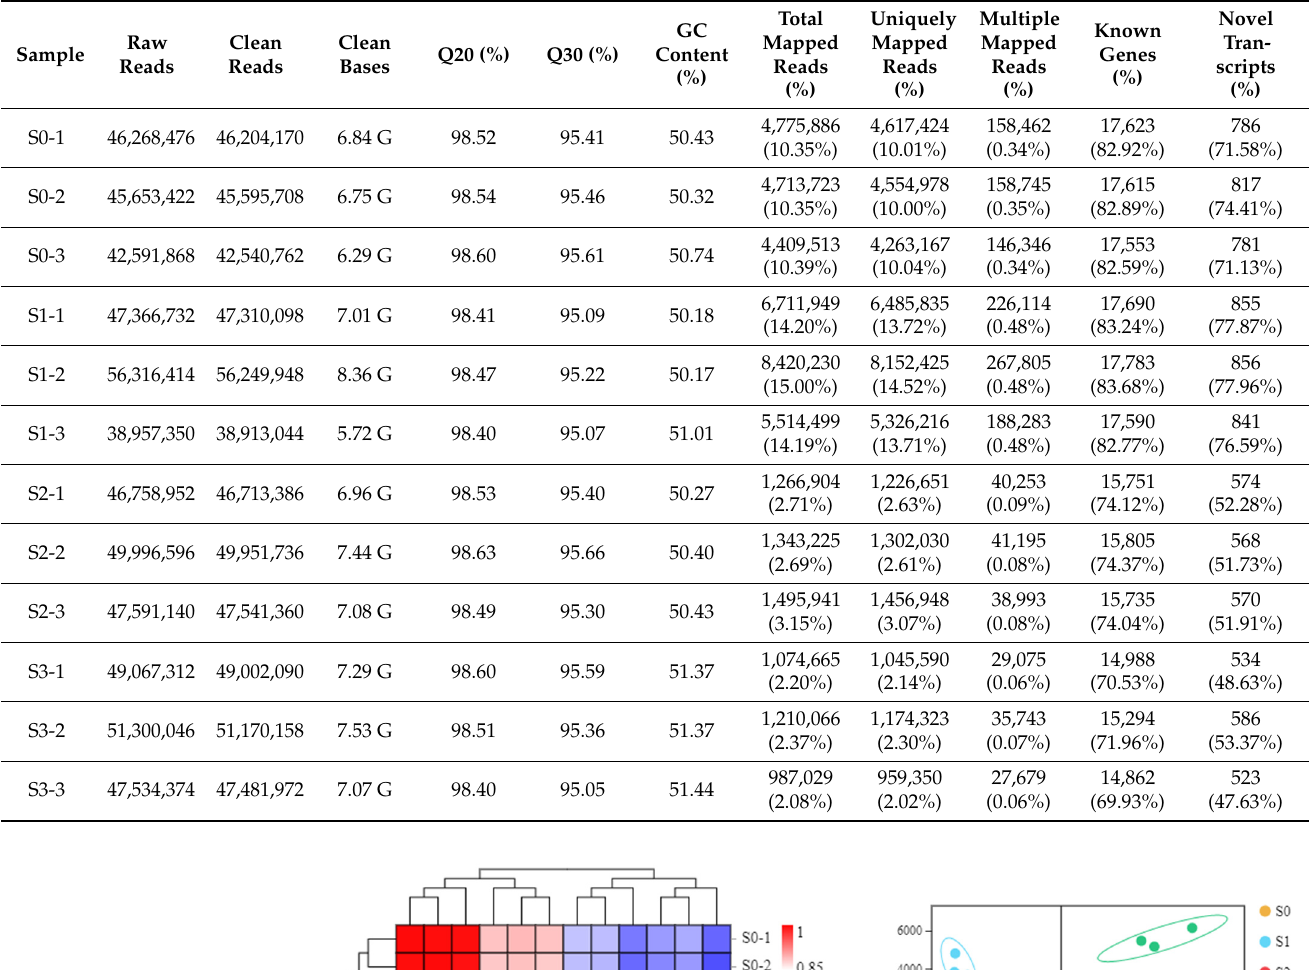
Table 1. Summary of the transcriptome sequencing data of the 12 libraries constructed using corresponding samples at the four statuses.